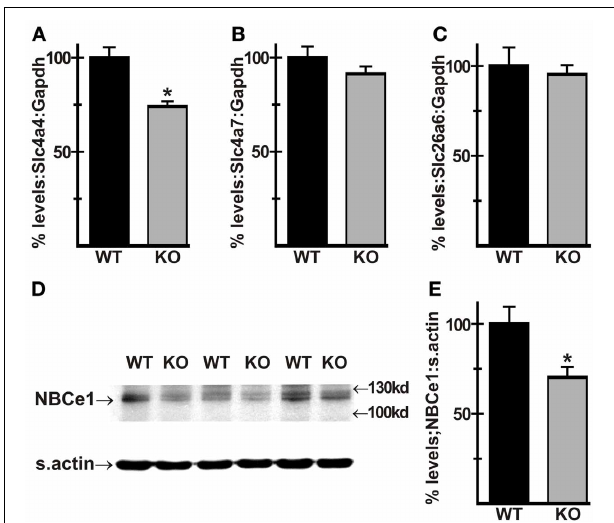
FIGURE 4 | Expression of HCO − 3 transporters in AE3-null hearts. RT-PCR analysis of cDNA generated from total RNA of WT and AE3-null (KO) hearts was carried out to determine mRNA levels the Slc4a4 and Slc4a7 Na + /HCO − 3 cotransporters and Slc26a6 , encoding the anion exchanger PAT1. When normalized to Gapdh levels, expression of Slc4a4 was downregulated in AE3-null hearts (A) , while Slc4a7 (B) and Sl26a6 (C) levels showed no change. Total cardiac homogenates of WT and KO hearts were subjected to immunoblot and densitometric analyses as described in Figure 3 ; results show that NBCe1 protein expression, when normalized to levels of sarcomeric actin (s.actin) was reduced in AE3-null hearts (D,E) . Values shown are mean ± S.E. n = at least 10 mice of each genotype for RT-PCR analysis and at least 7 mice of each genotype for immunoblot analysis. ∗ p < 0 . 02 vs.